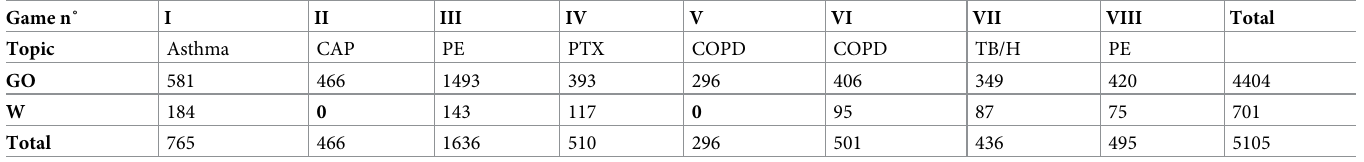
n˚ = number; GO = number of Game Overs; W = number of finished rounds; CAP = community-acquired pneumonia; PE = pulmonary